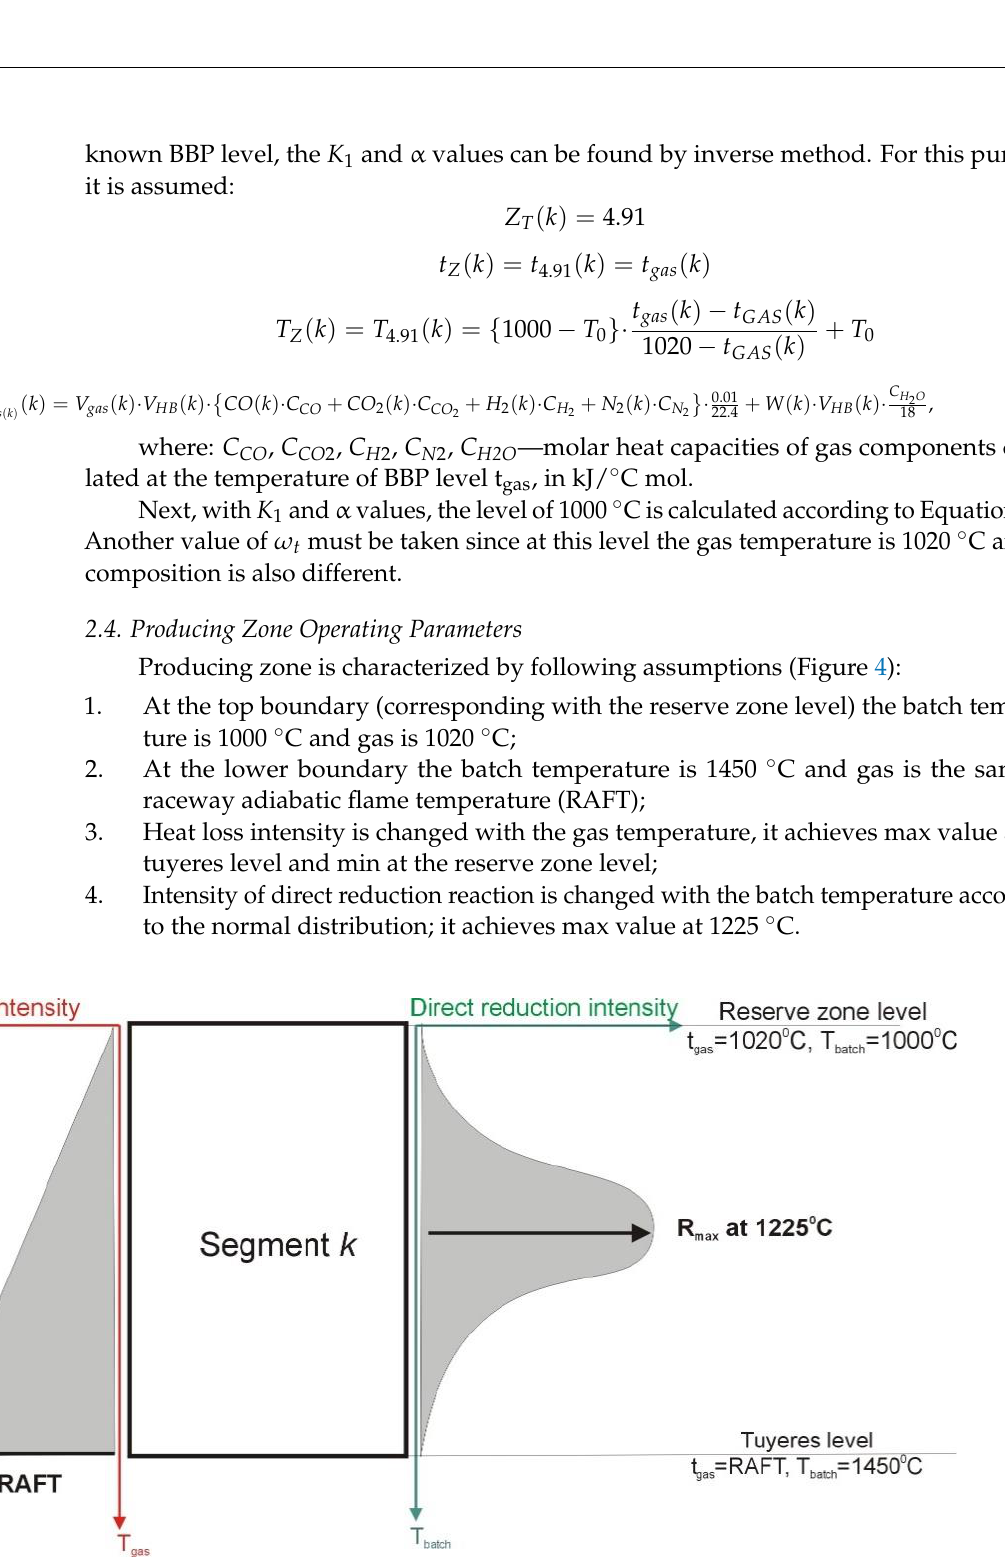
Figure 4. Assumptions for producing zone.